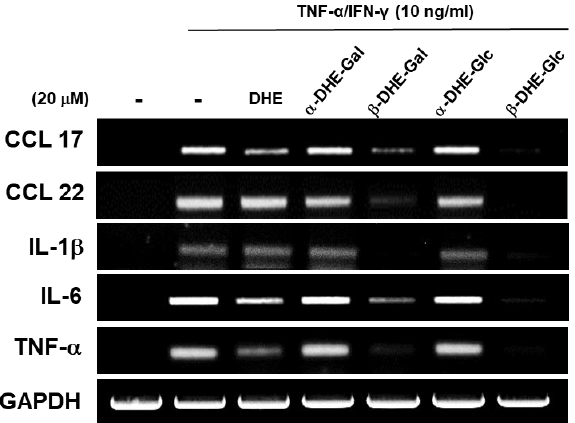
Figure 3. Effects of α- and β-anomers of DHE-Glc and DHE-Gal ( 2 , 3 , 4 , and 5 ) on pro-inflammatory cytokine and chemokine gene expression. To determine the effects of synthetic α- and β-anomers of DHE-Glc and DHE-Gal on pro-inflammatory cytokine IL-1b, IL-6, and TNF-α expression, mRNA levels were determined using an RT-PCR assay. mRNA expression levels of the chemokines CCL17 and CCL22 were compared under similar conditions. RT-PCR reactions were performed in triplicate and repeated at least three times.